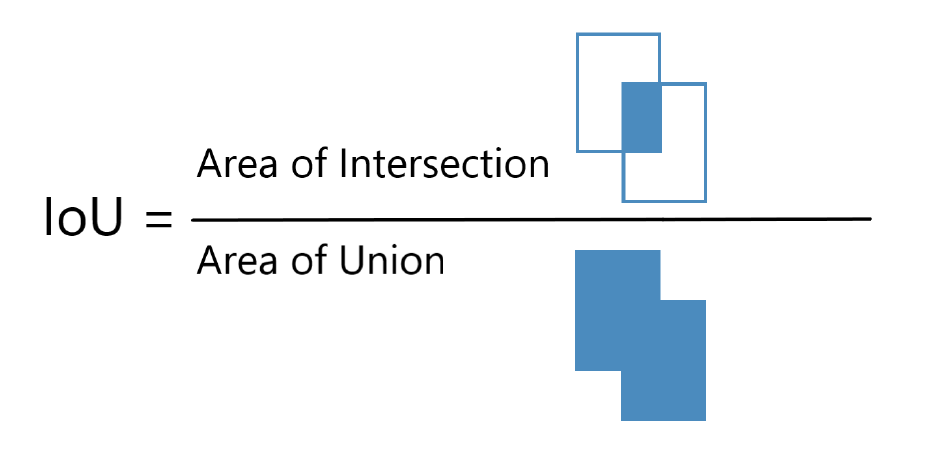
Figure 8. Intersection over Union